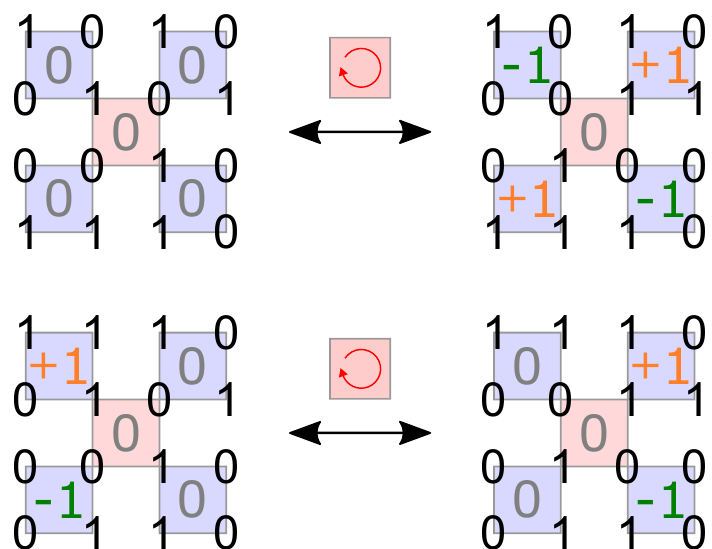
Figure 24: Fracton-like dynamics of the charges on the blue sublattice upon the flip of the plaquette on the red sublattice: (top panel) new charges can be created only in quadrupoles, which are free to move in the plane, (bottom panel) a dipole of charges can move only in the direction perpendicular to its dipole moment. A single charge remains immobile under the dynamics of the XY-plaquette